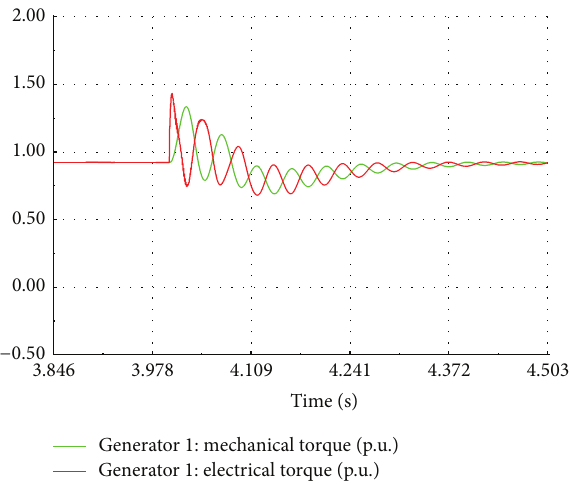
Figure 20: Substation bus 11kV: line to line voltage in kV.